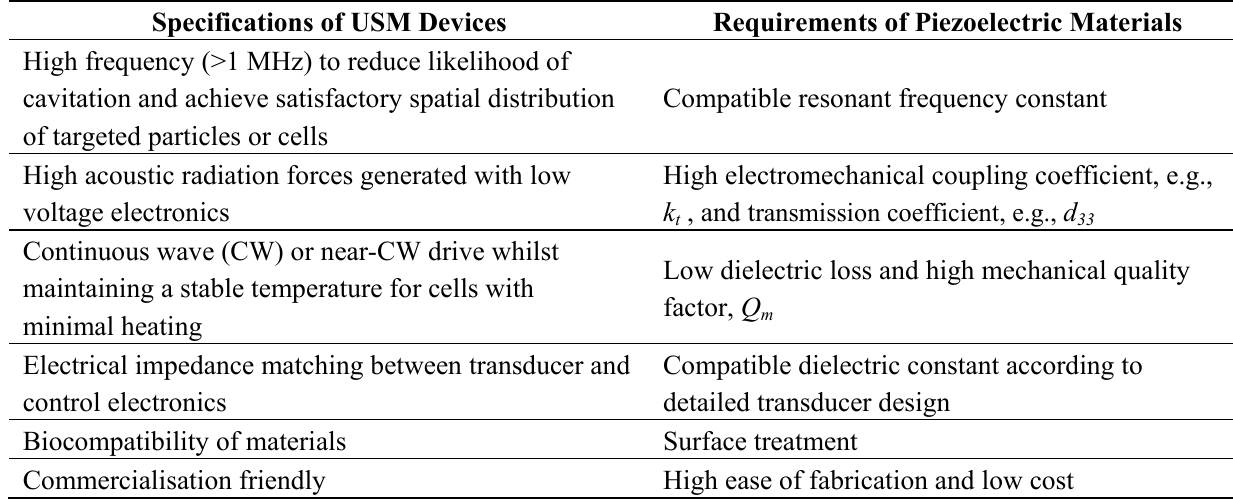
Table 2. Basic specifications of USM devices with corresponding requirements in the selection of piezoelectric